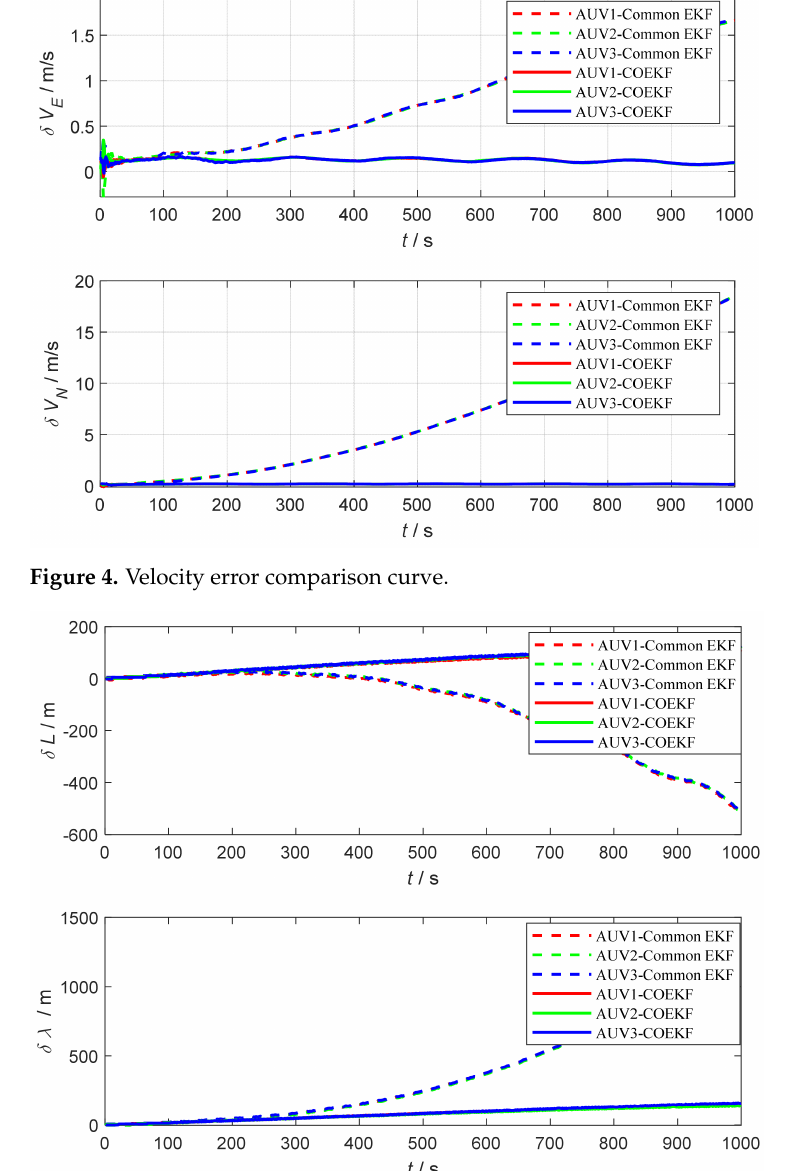
Figure 5. Position error comparison curve. The relative horizontal distance error curves for cooperative multi-AUV navigation based on the combined-observation EKF are shown in Figure 6; the red, green, and blue dashed lines show the relative horizontal distance error curves between AUV1 and AUV2, between AUV1 and AUV3, and between AUV2 and AUV3, respectively, when autonomous navigation is based on pure SINS. The red, green, and yellow solid lines show the relative horizontal distance error curves between the individual AUVs based on the combined- observation EKF for cooperative navigation. The horizontal distance error statistics for multi-AUV cooperative navigation based on the combined-observation EKF are shown